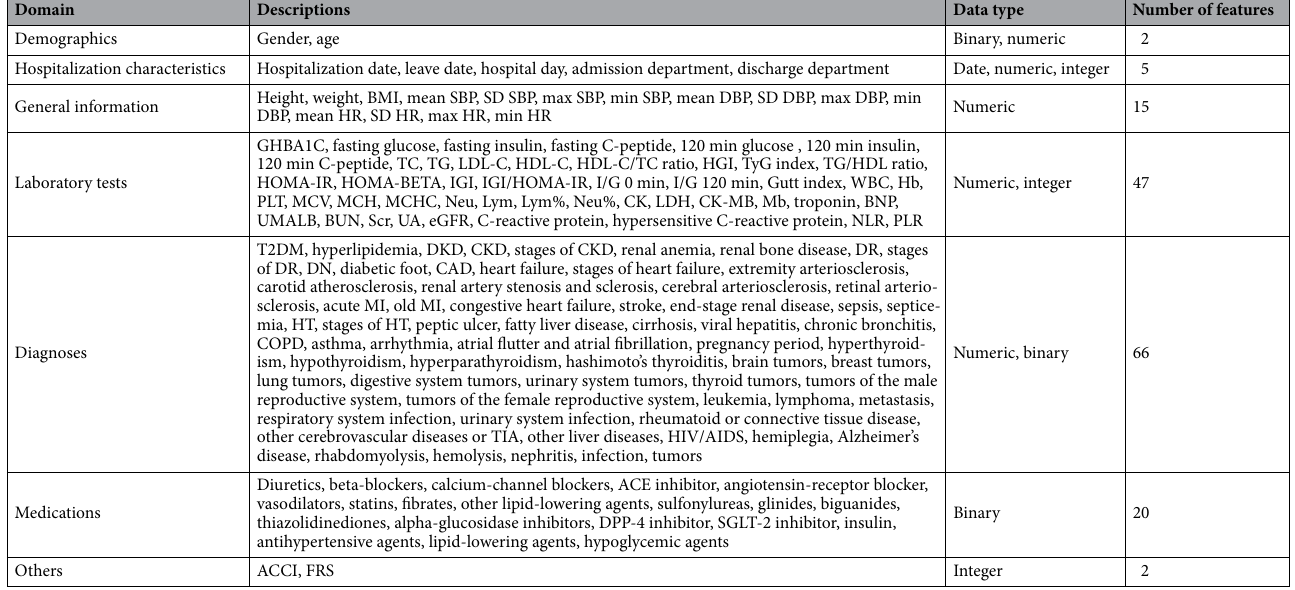
Table 2. Data domain categories and descriptions. SBP systolic blood pressure, DPB diastolic blood pressure, HR heart rate, GHBA1C glycated hemoglobin A1c, TC total cholesterol, TG triglycerides, LDL-C